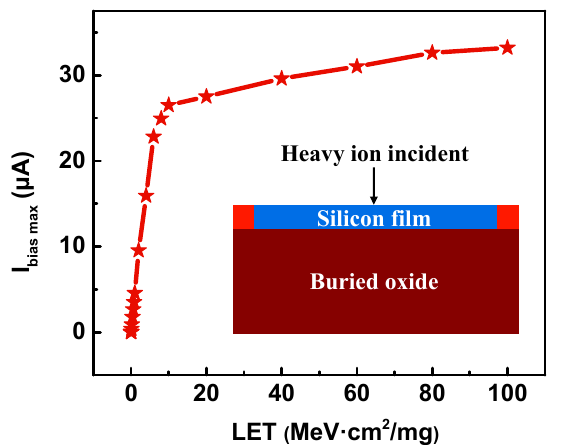
Figure 8. The change of the detected maximum bias current ( I bias ) with linear energy transfer (LET). The inset shows a schematic diagram of heavy ion incidence.